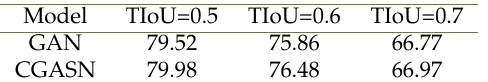
Table 4. Comparison of CGASN and GAN results under